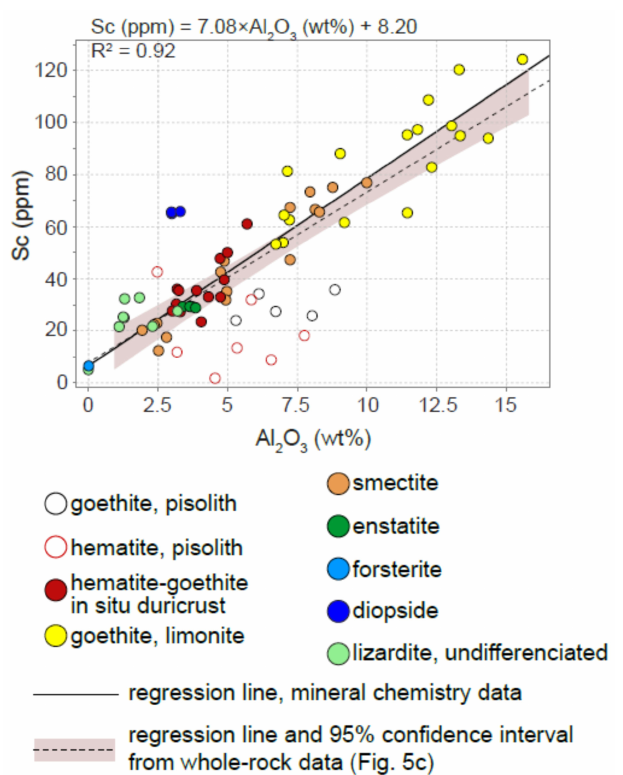
Figure 8. Sc-Al 2 O 3 scatterplot and regression line obtained for silicates, smectite, and iron oxides in the East Alpha deposit (Ti é baghi massif) from LA-ICP-MS analyses. The regression line calcu- lation excluded spot analyses of diopside from the bedrock and of goethite and hematite from the nodular/pisolitic